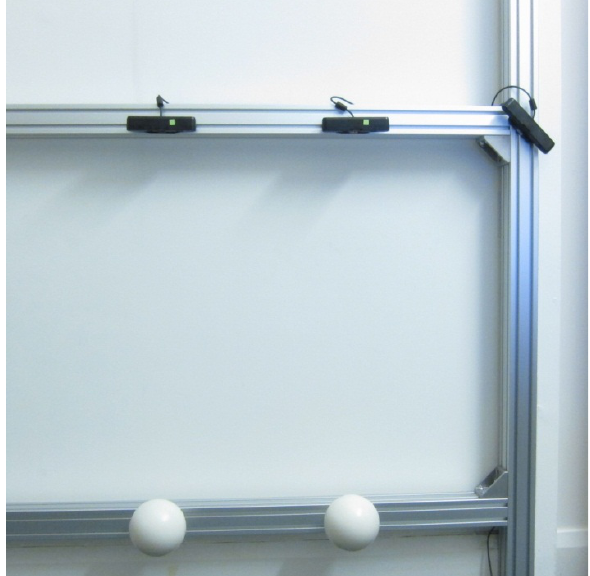
Figure 3. Test set up for repeatedly measuring the distance of two spheres, both with and without interference from other sensors.